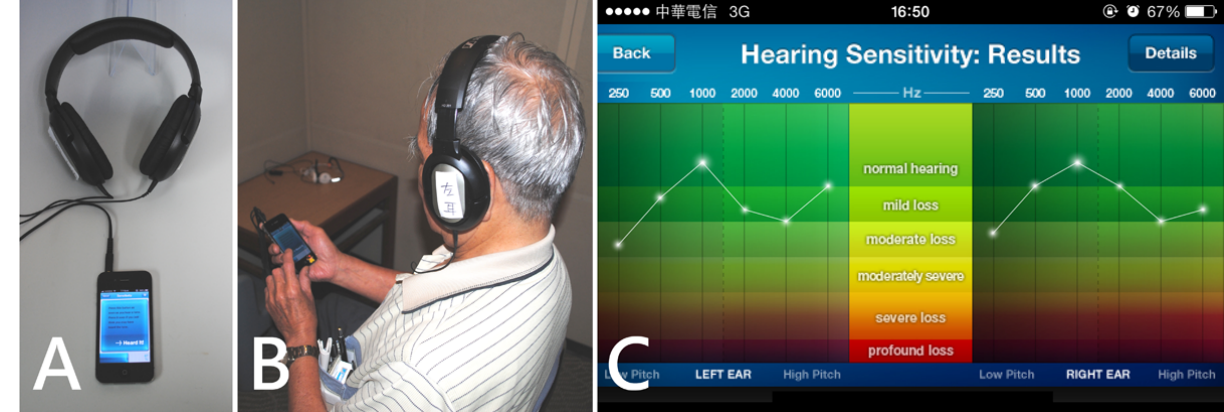
Figure 3. Smartphone-based audiometry hearing screening test. A: Smartphone-based audiometry device. B: Demonstration of smartphone-based audiometry. C: Results of hearing sensitivity shown in a typical audiogram